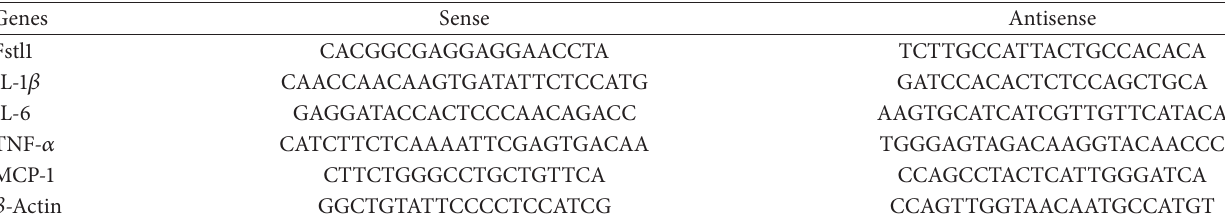
Table 1: Primer sequences for real-time